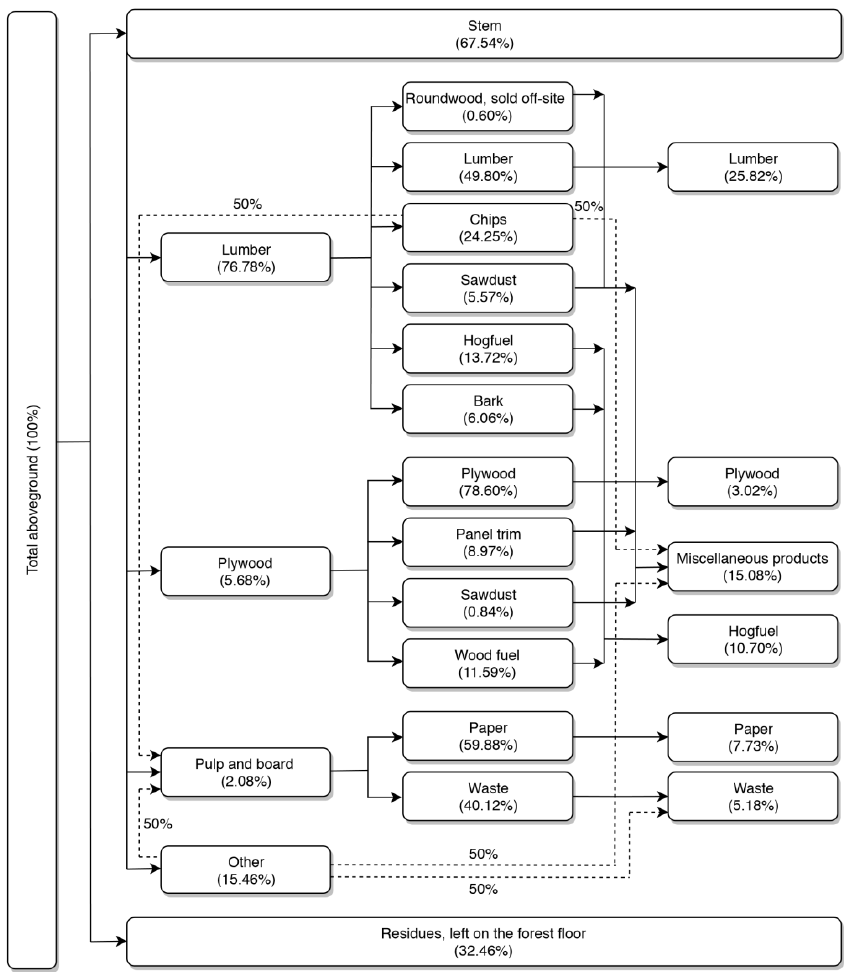
Figure 2. Input and output flows for the production of different wood products, on a dry mass basis.